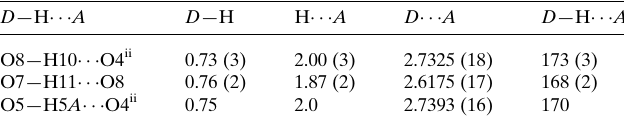
Table 2 Hydrogen-bond geometry (A˚ , (cid:5) ).